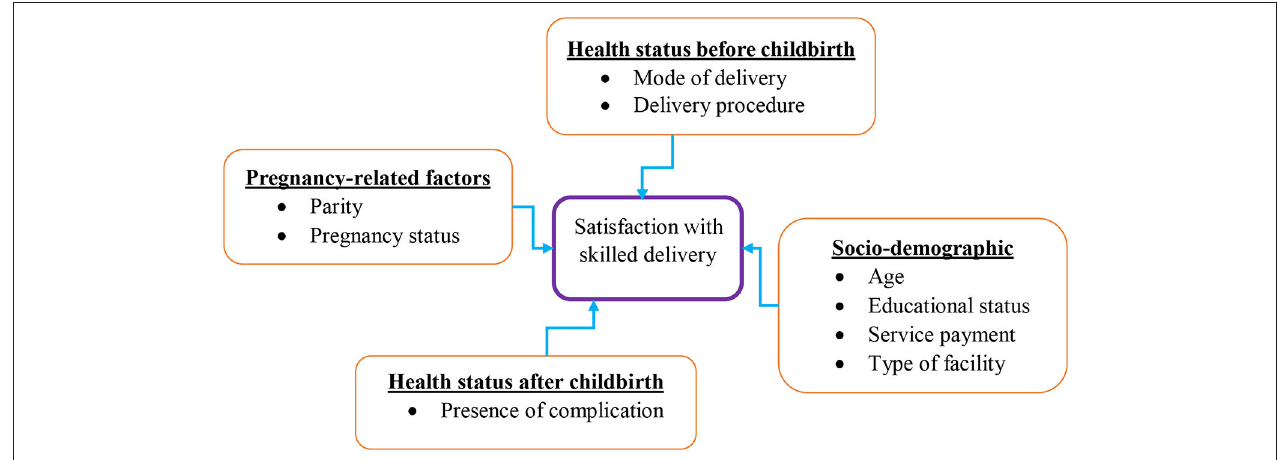
FIGURE 1 | A conceptual framework showing factors associated with satisfaction with skilled